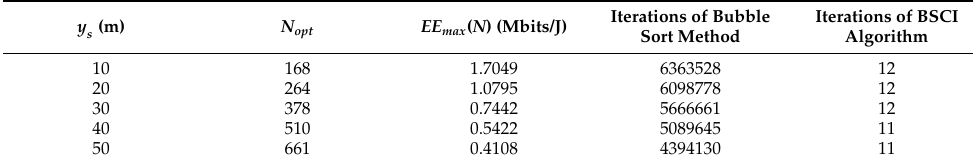
Table 5. N opt and iterations with different y s